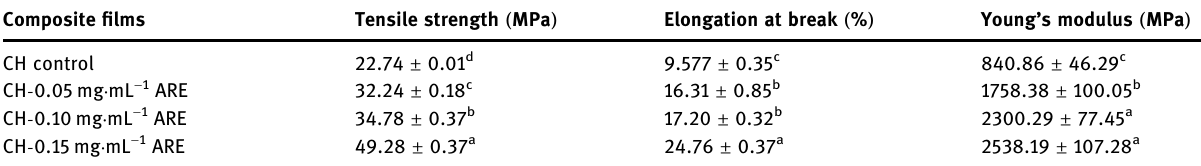
Table 3: Tensile strength, elongation at break, and Young ’ s modulus of CH/ARE composite fi lms containing di ff erent concentrations of ARE